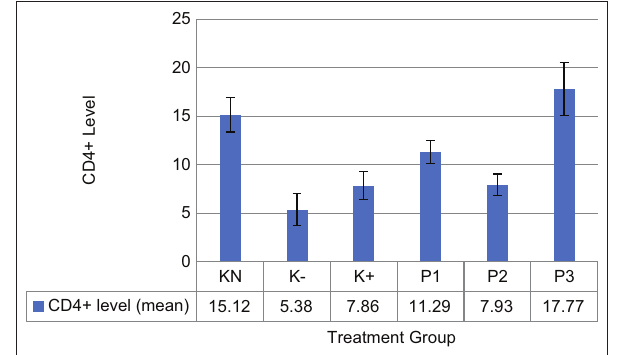
Figure-2: Effect of the ethanolic extract of red okra pods on the activity of CD4+ T cell. KN=Normal control, K−=Negative control, K+=Positive control. P1, P2, and P3=Administrated with 50, 100, and 200 mg/kg body weight ethanolic extract of red okra pods. Each bar represents means±standard deviation (n=5). *p<0.05 compared to the negative control. **p<0.05 compared to negative control and positive control. ***p<0.05 compared to all groups.